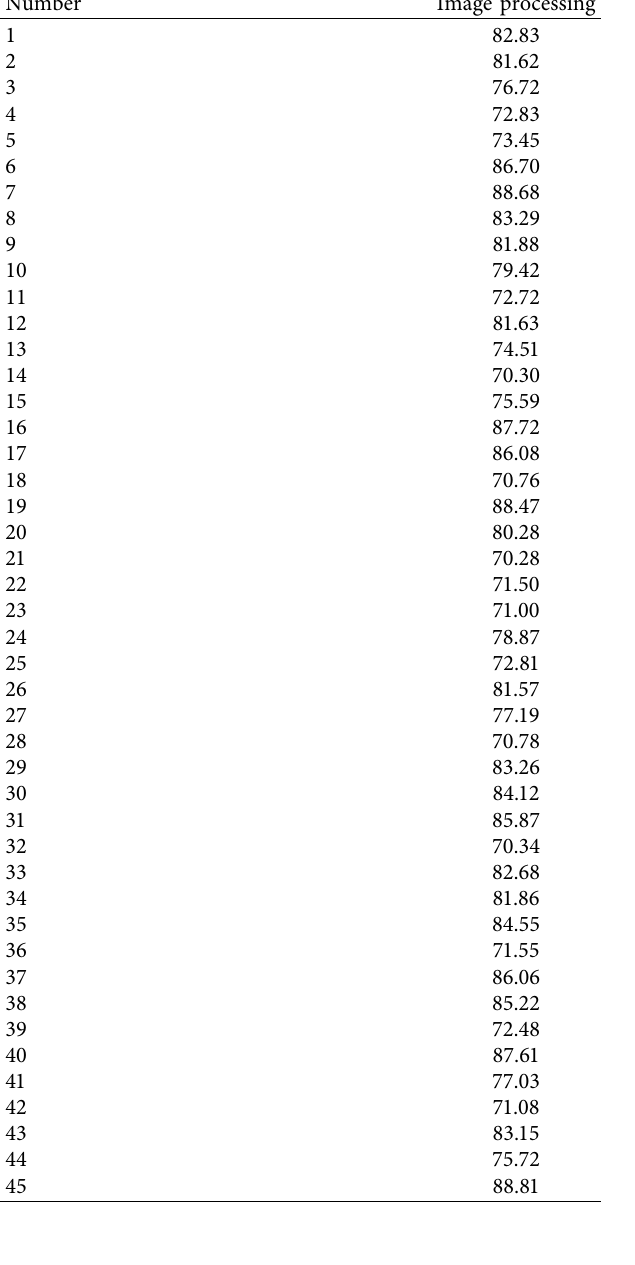
Table 1: The effect of computer image processing. Table 2: UI design